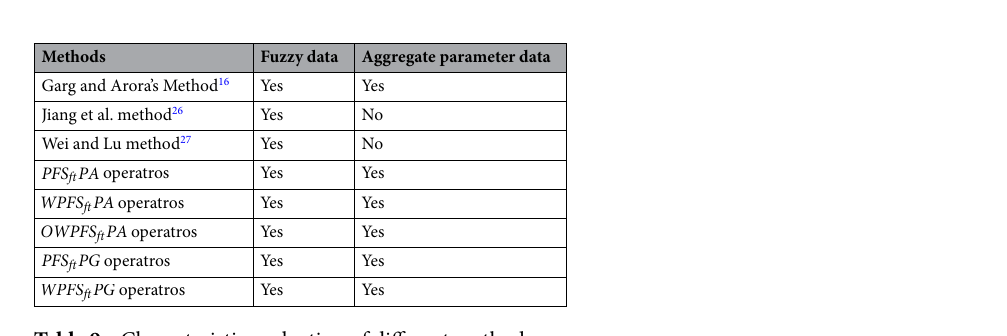
Table 9. Characteristic evaluation of different